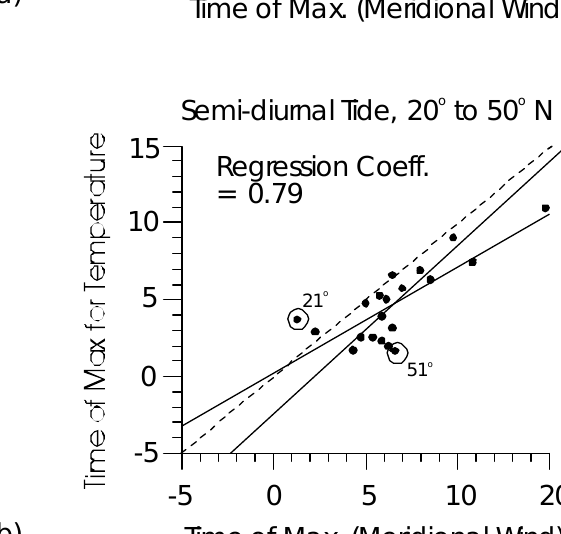
c:\wkh\egs\mtidef14.cdr